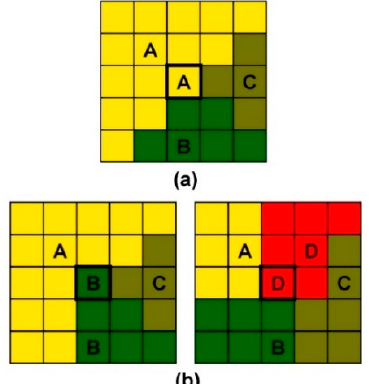
Figure 3. Examples of a 5 by 5 training patch candidate with di ff erent class compositions and configurations; ( a ) a case that can be a training patch for class A with a class purity value of 60%; ( b ) cases that cannot be a training patch for class A. The box with thick lines denotes a center pixel of a training patch. Di ff erent colors refer to di ff erent classes.